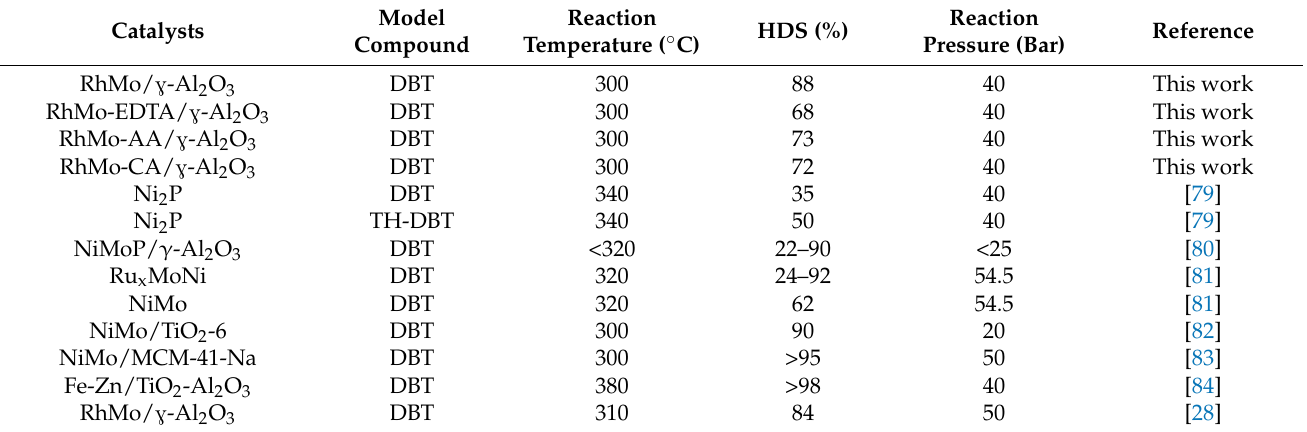
Table 6. Comparison of catalyst performance with literature reports in DBT